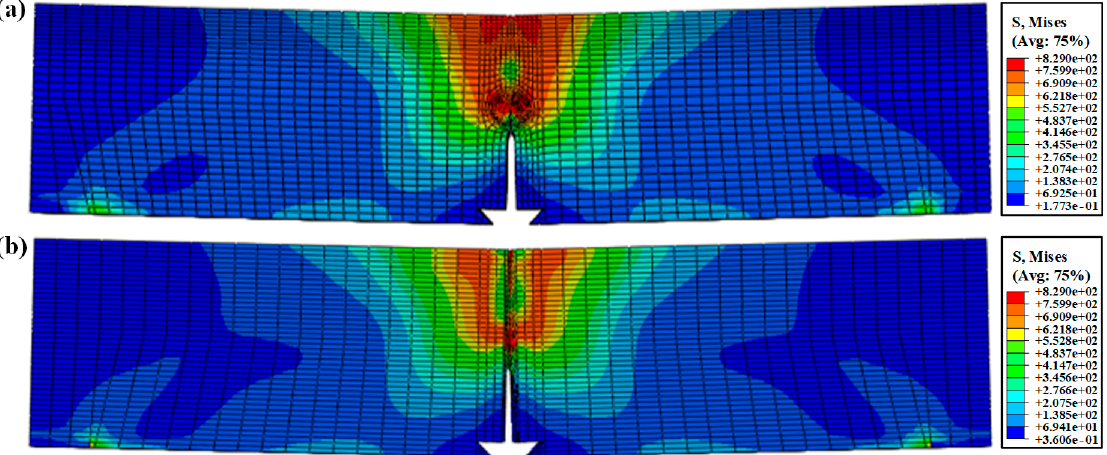
Figure 8. Overall stress distributions of the specimens: ( a ) SENB20 without side grooves; ( b ) SENB20 with side grooves.